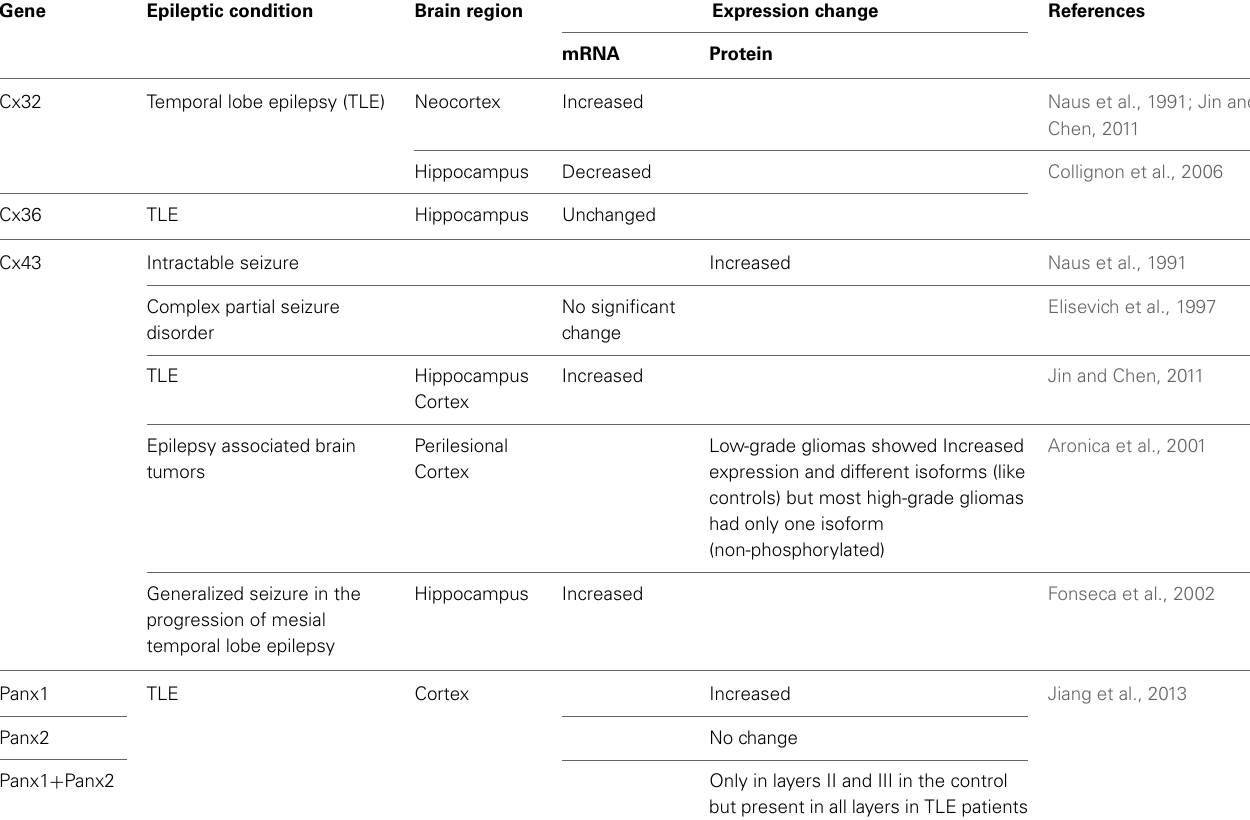
Table 2 | Gap junctional expression changes associated with human